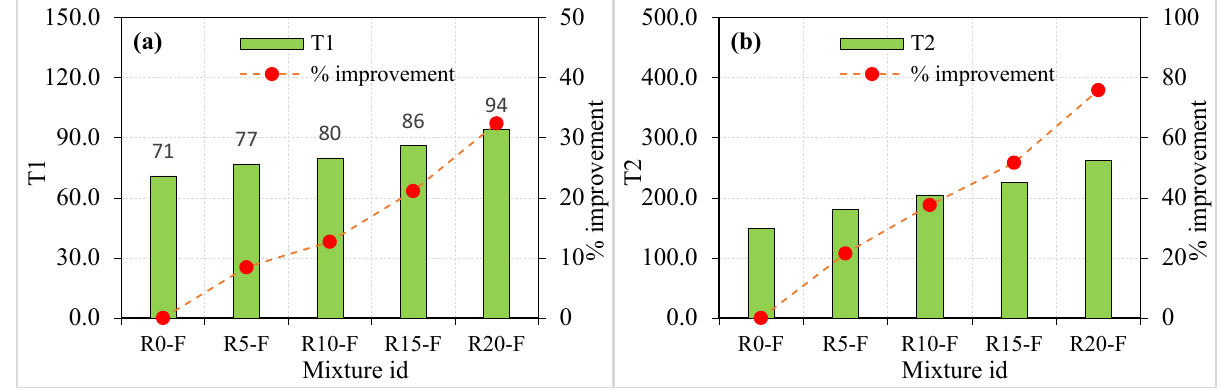
Figure 7. Impact strength of fibrous specimen ( a ) T1 and ( b ) T2.